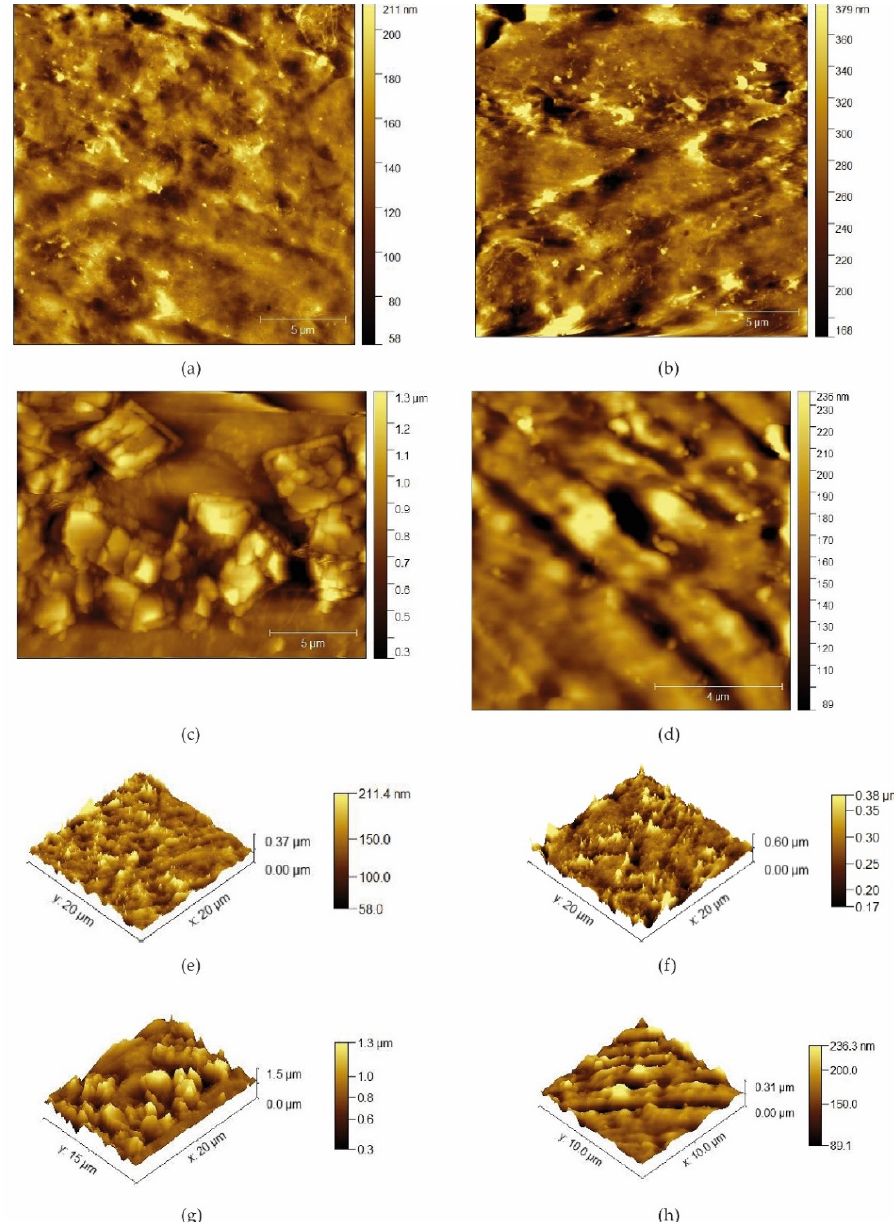
Figure 2. Topographical AFM images of d-U(600) ∞ ( a , e ), d-U(900) ∞ ( b , f ), d-U(600)LiBF 4 -[Bmim]Cl ( c , g ) and d-U(900)LiBF 4 -[Bmim]Cl ( d , h ). The ionic conductivity of d-U(900)LiBF 4 -[Bmim]Cl (Figure 4b—red symbols) attained 8.10 × 10 − 5 at room temperature and 2.8 × 10 − 4 S · cm − 1 at 55 ◦ C. We can compare